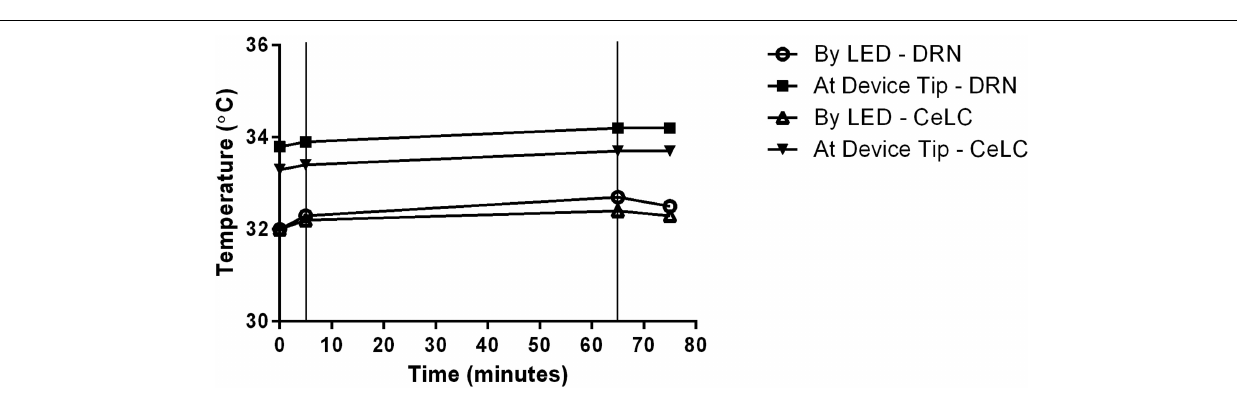
Frontiers in Neuroscience |